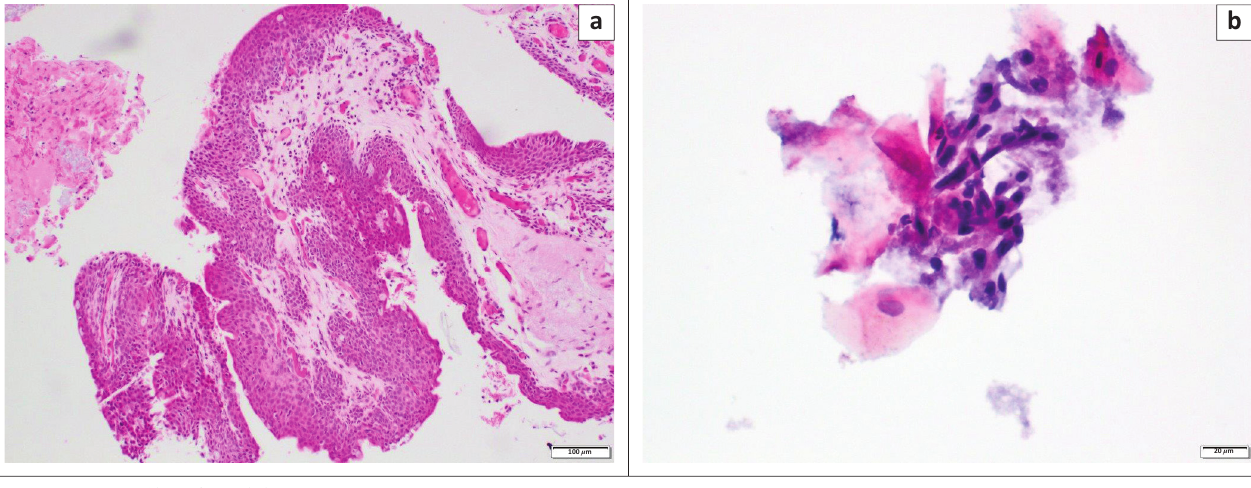
Source : Images captured by Prof. P. Michelow FIGURE 2: (a) Conjunctival biopsy comprising thickened epithelium with full thickness involvement by dysplastic cells showing a high nuclear:cytoplasmic ratio. The basement membrane remains intact. This is consistent with a pterygium showing conjunctival intra-epithelial neoplasia 3/high grade squamous intraepithelial lesion (haematoxylin + eosin, ×100 magnification). Case courtesy of Dr Eunice van der Berg, University of the Witwatersrand and National Health Laboratory Service, Chris Hani Baragwanath Hospital, Johannesburg. (b) Impression cytology of the same case demonstrating loosely cohesive clusters of squamous cells with a very high nuclear:cytoplasmic ratio, irregular nuclear contours and hyperchromasia consistent with a high-grade squamous intraepithelial lesion (ThinPrep, Papanicolaou stain,